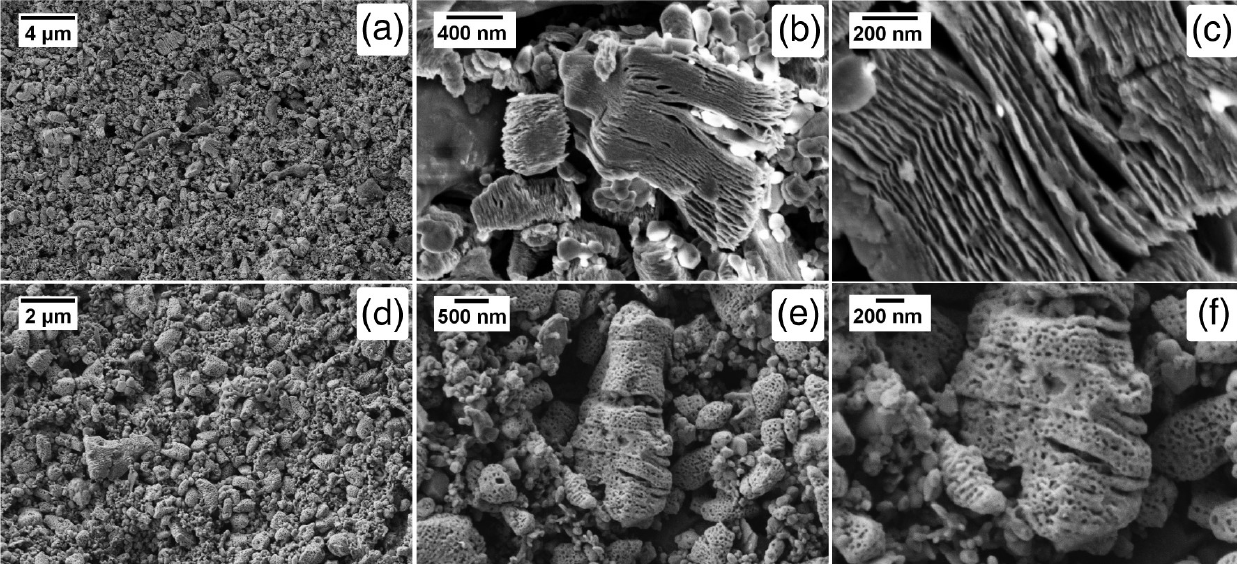
Figure 3. SEM micrographs of V 2 CT x MXene film on Al 2 O 3 /Pt substrates before ( a – c ) and after ( d – f ) oxidation.